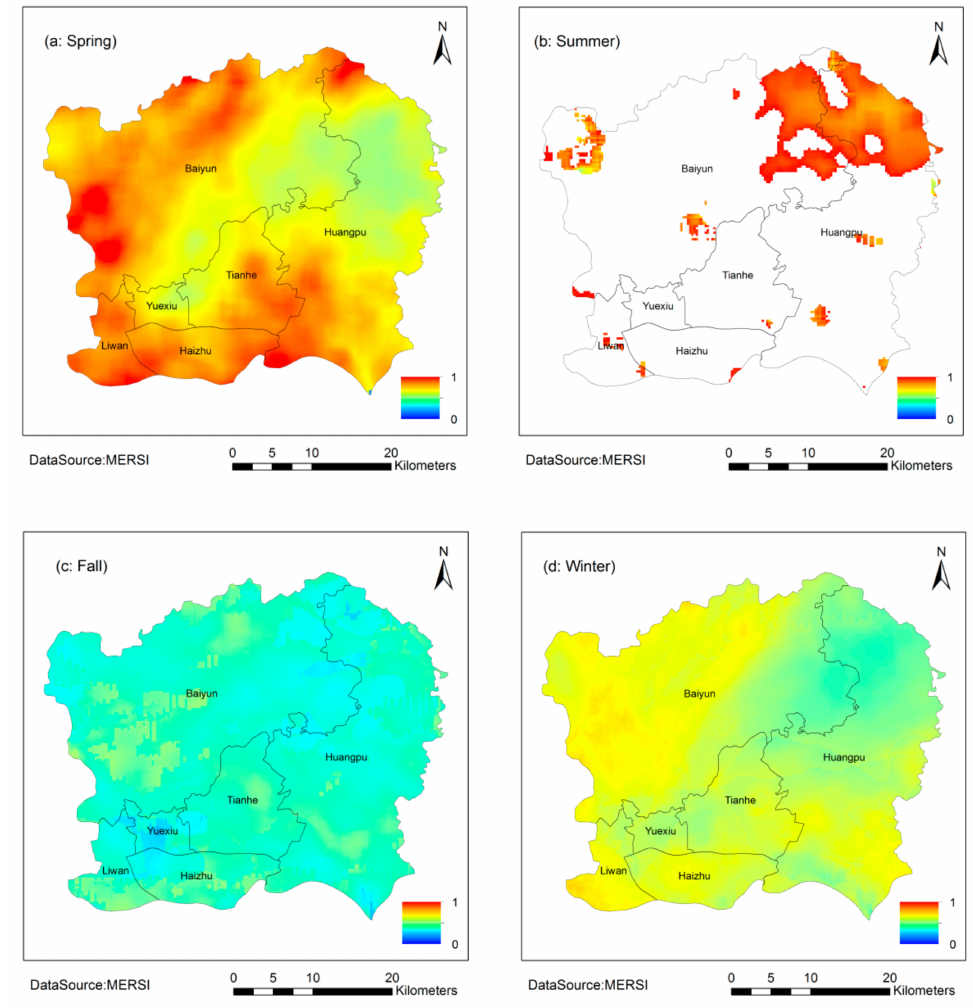
Figure 9. AOD in four seasons of